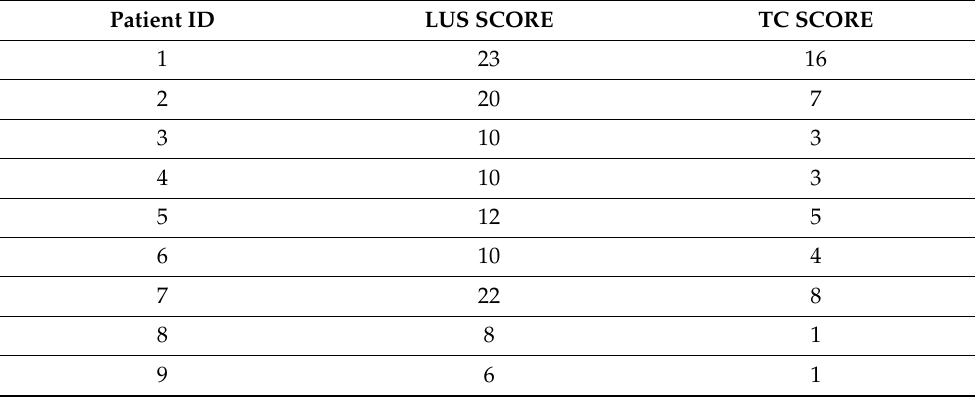
Table 3. LUS and CT scores in the 9 women who underwent both